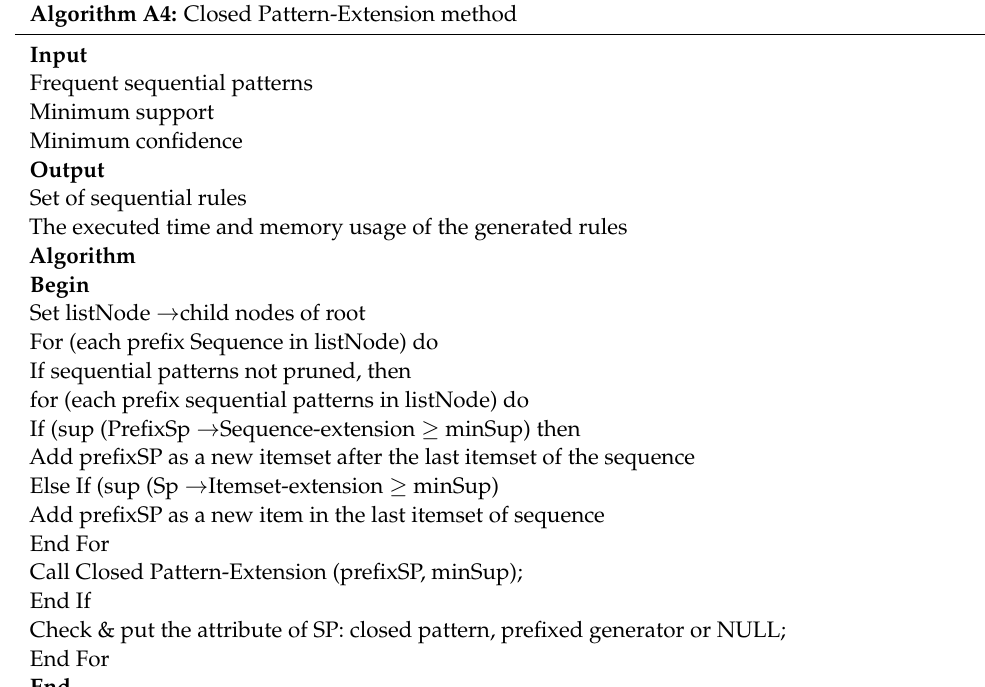
Algorithm A4: Closed Pattern-Extension